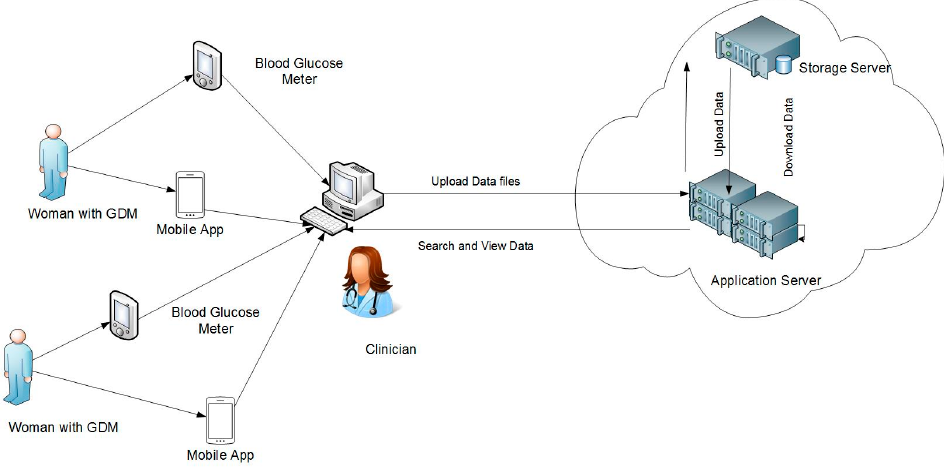
Figure 1. Clinical ecosystem integrating patient generated wellness data: a conceptual view.